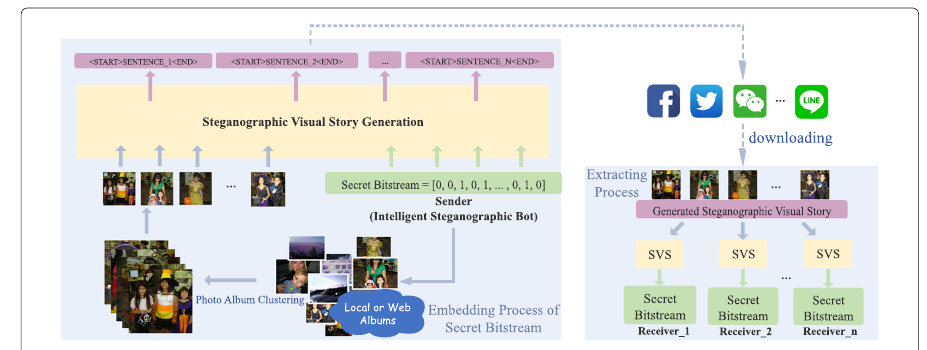
Fig. 1 The process of posting secret information on social network